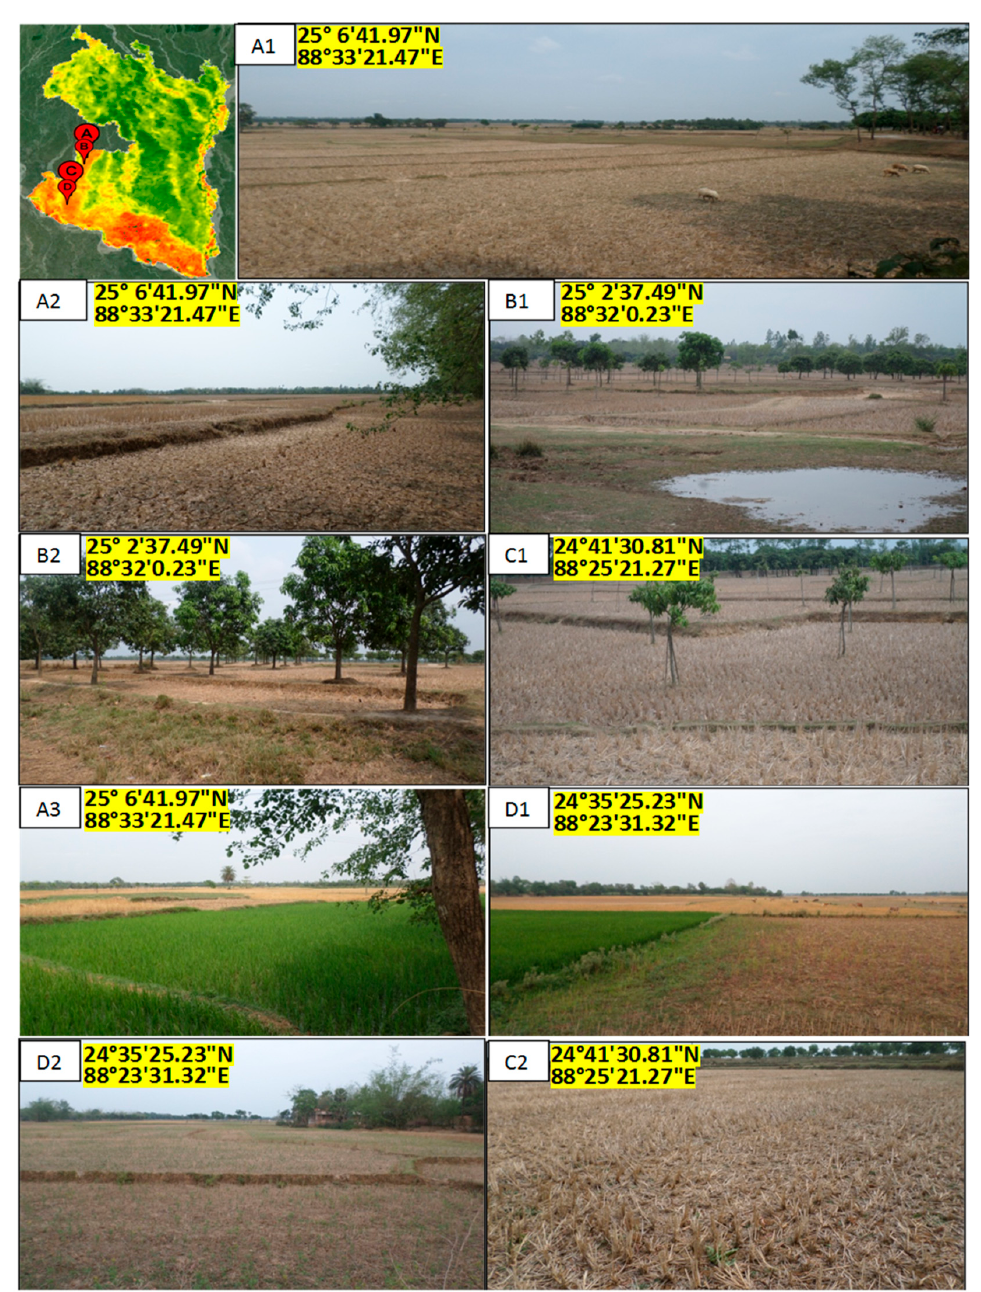
Figure 9. Field observations in highTVDI area in the High Barind Tract (HBT) region.